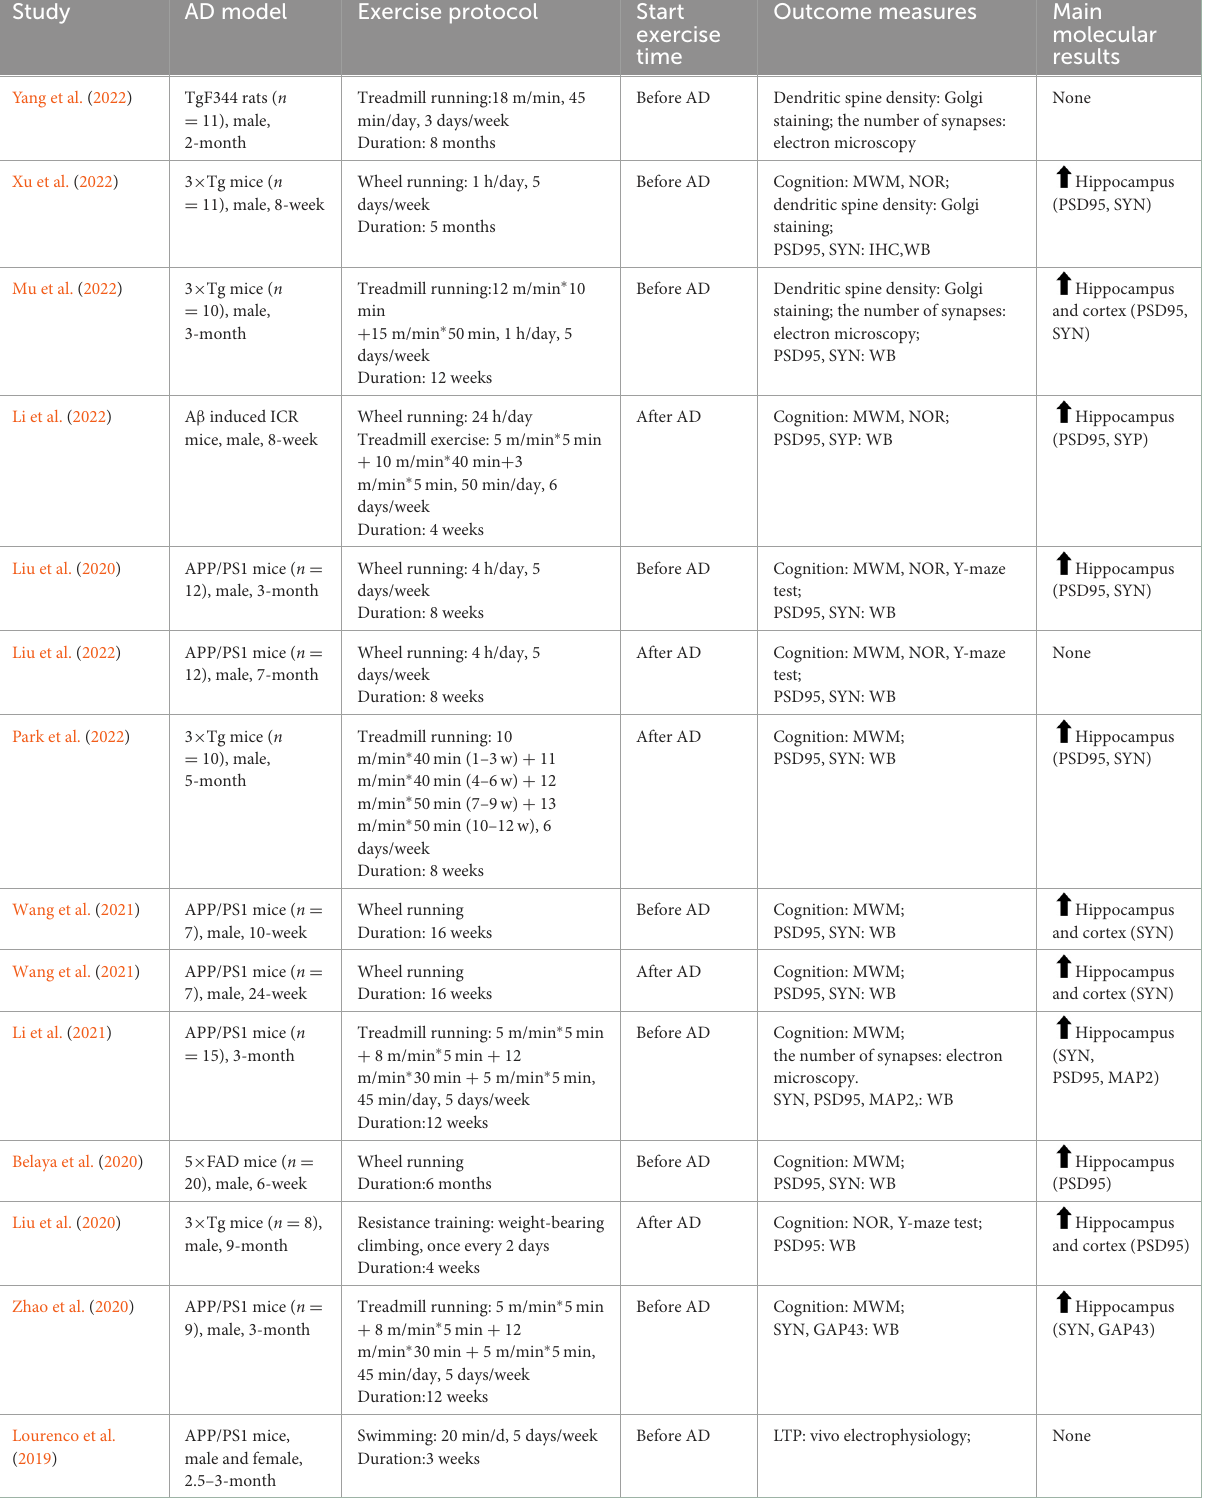
TABLE 1 Characteristics of the included studies.